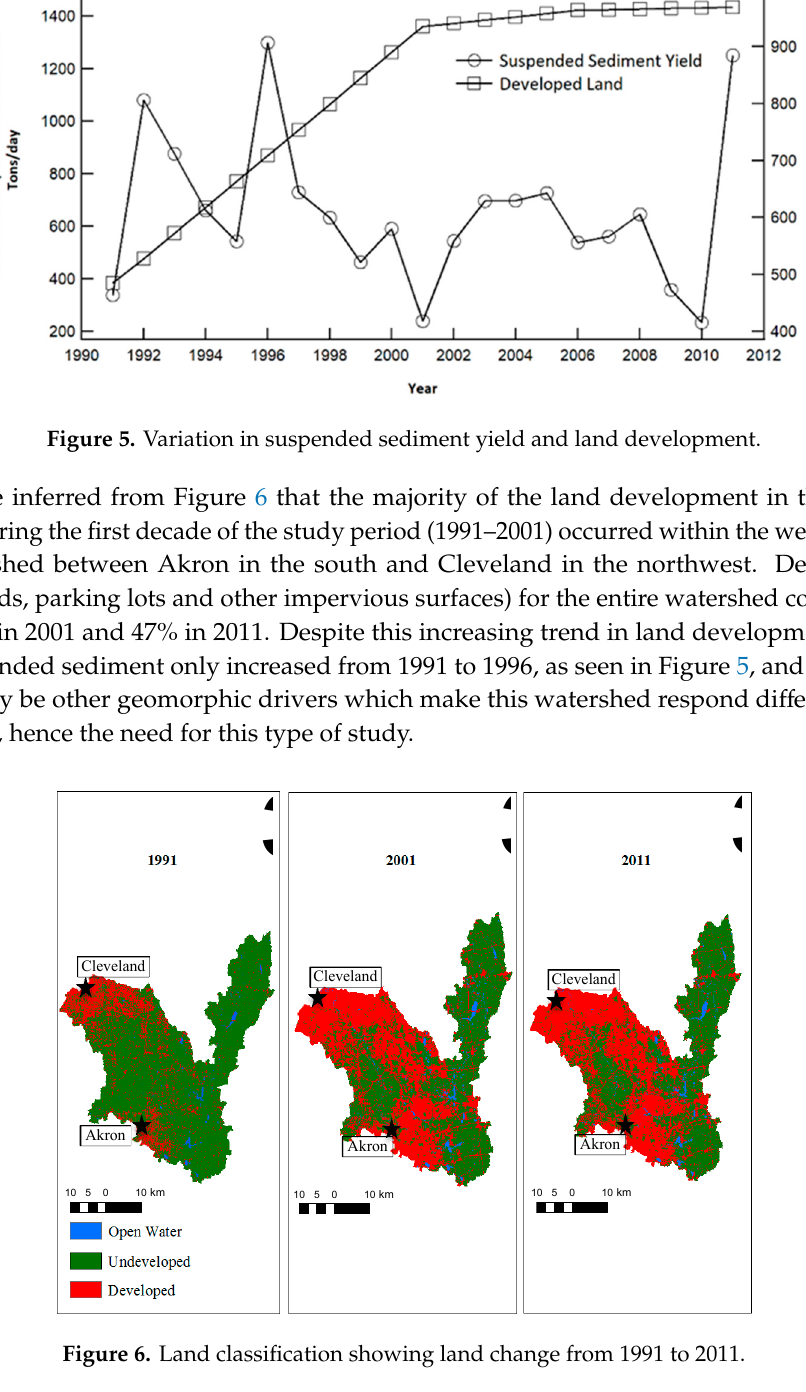
Figure 4. Time series trend of land-cover change within the Cuyahoga watershed.